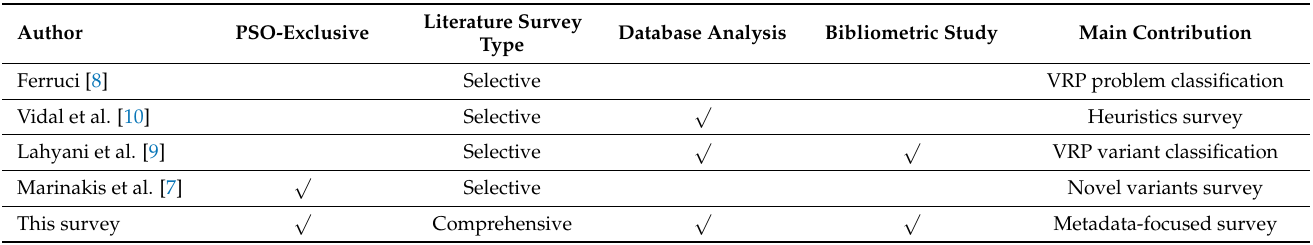
Table 1. Research gap table for significant VRP heuristics literature review